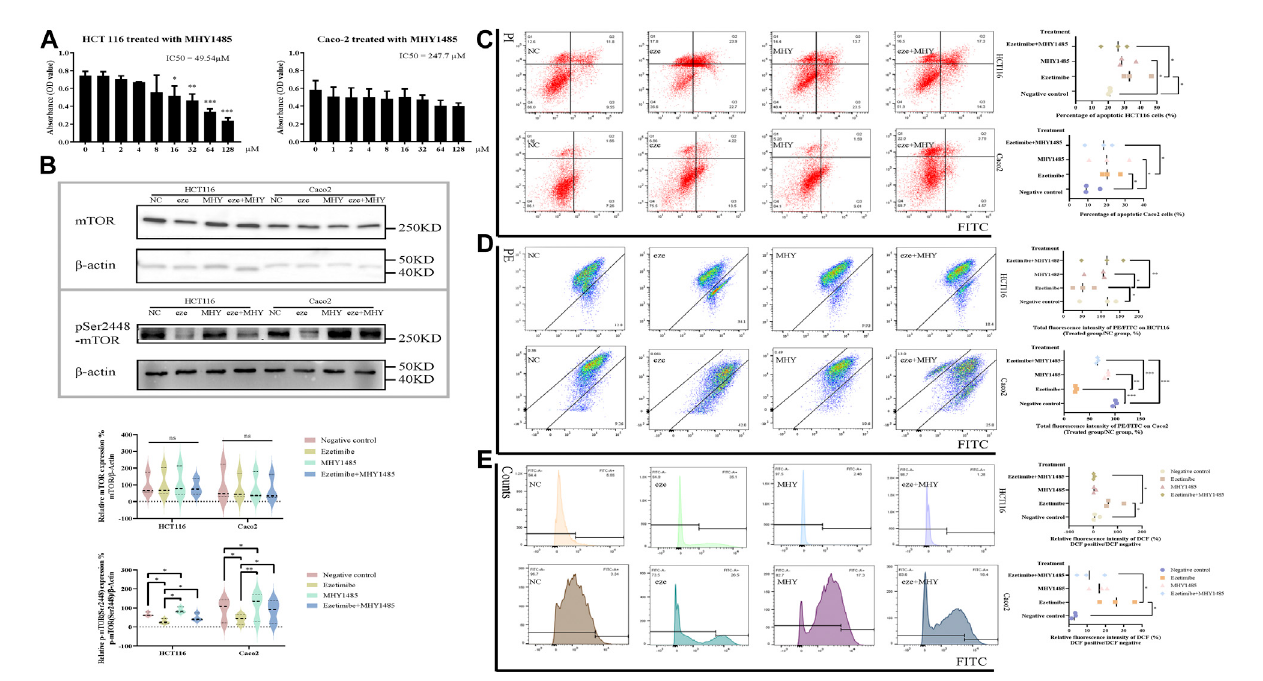
FIGURE 5 CRC cell apoptosis and mitochondrial dysfunction can be partly rescued by mTOR activator MHY1485. (A) Effects of MHY1485 on the viability of HCT116 and Caco2 cells at 48 h detected by CCK-8 assay. (B) Protein expression of mTOR and mTOR pSer1448 in the groups of negative control, ezetimibe, MHY1485 and ezetimibe + MHY1485 for HCT116 and Caco2 cells. (C) Apoptosis of HCT116 and Caco2 cells for groups of negative control, ezetimibe, MHY1485 and ezetimibe + MHY1485 with Annexin V-FITC/PI staining fl ow cytometry. (D) Fluorescence intensity of JC-1 for groups of negative control, ezetimibe, MHY1485 and ezetimibe + MHY1485 on HCT116 and Caco2 cells with fl ow cytometry. (E) Fluorescence intensity of DCF for groups of negative control, ezetimibe, MHY1485 and ezetimibe + MHY1485on HCT116 and Caco2 cells with fl ow cytometry. * p < 0.05, ** p < 0.01, *** p < 0.001, **** p <